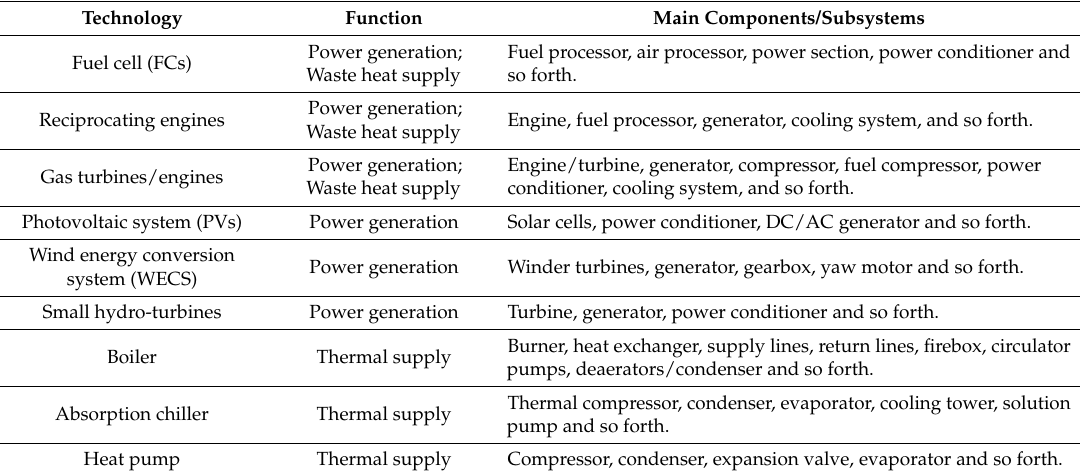
Table 1. The main components of the CCHP system